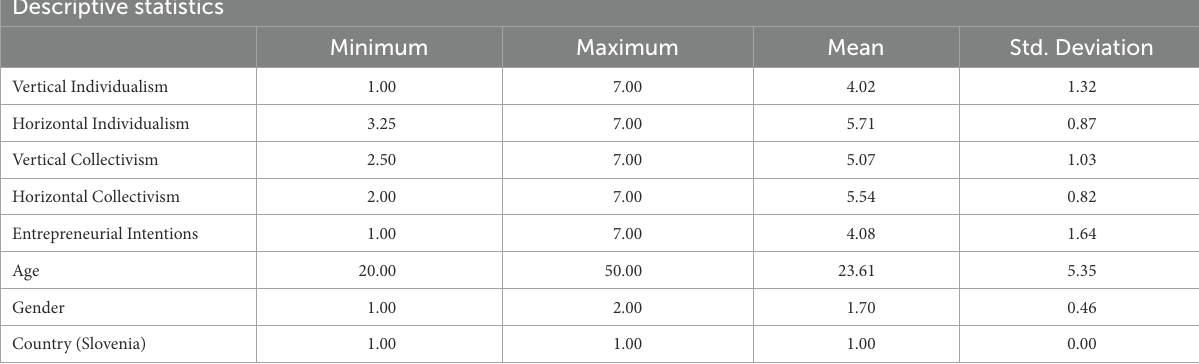
TABLE 3 Study 2 descriptive statistics.